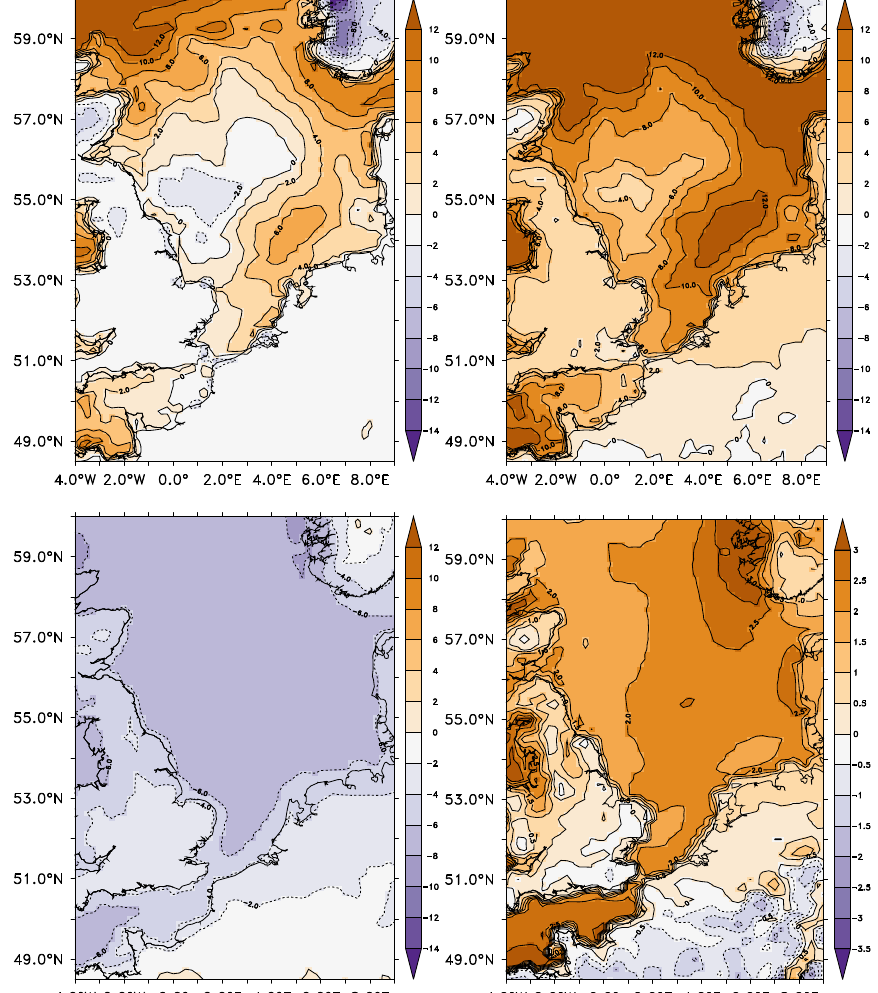
Figure 8. Climatological annual mean changes in net heat flux (W/m 2 ) ( upper left ), non-solar heat flux (W/m 2 ) ( upper right ), shortwave radiation (W/m 2 ) ( lower left ), and total cloud cover (1/100) ( lower right ) of the RCA4-NEMO RCP8.5 ensemble mean between periods P0 and P2. Blue colors indicate increased heat loss or decreased heat gain of the North Sea,